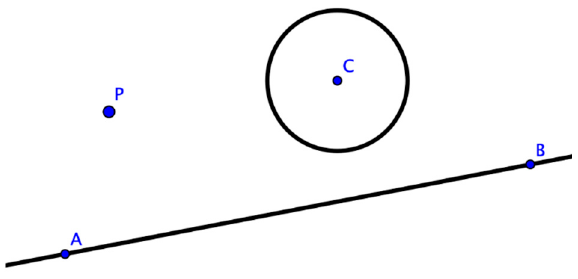
Figure 8. How to draw a tangent circle to line AB and to circle with center C and that passes through point P?